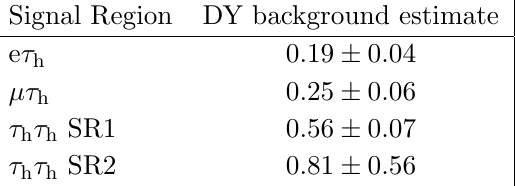
Table 4 . The DY background contribution estimated from simulation in four signal regions. The uncertainties are due to the limited number of MC